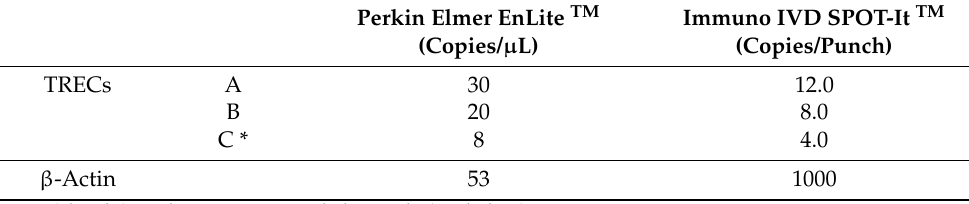
Table 1. Cut-off values for TRECs and β -Actin. Perkin Elmer EnLite TM Immuno IVD SPOT-It TM (Copies/ µ L) (Copies/Punch) TRECs A 30 12.0 B 20 8.0